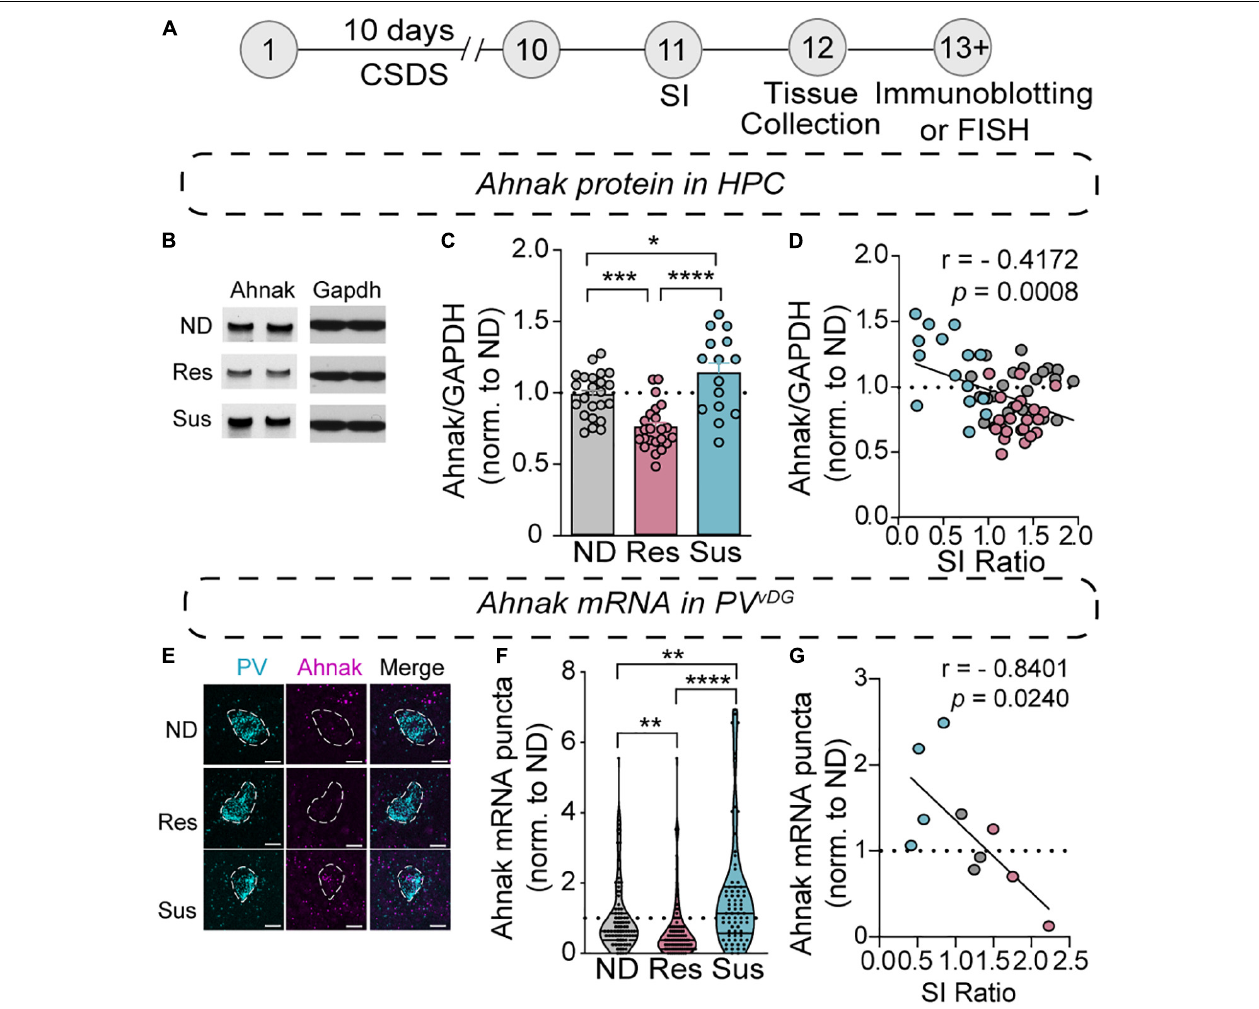
FIGURE 4 | Chronic social stress alters Ahnak expression in the hippocampus. (A) Diagram and timeline of CSDS and tissue collection. (B–D) Immunoblotting of Ahnak protein using hippocampal lysates. (B) Representative images of immunoblotting of Ahnak and Gapdh as a control. (C) Quantification of immunoblots [one-way ANOVA, Non-defeated ( n = 23 mice), Res ( n = 23 mice) and Sus ( n = 15 mice)]. (D) Hippocampal Ahnak is inversely correlated with SI ratio (pearson r : r = –0.4172, p = 0.0008, n = 61 mice) (E) Representative images PV and Ahnak mRNA expression using RNAScope. Scale bar, 5 µ m. (F) Ahnak mRNA expression in vDG PV neurons from Non-defeat, Res and Sus groups (Kruskal–Wallis test with post hoc Dunn’s multiple comparisons: Non-defeated ( n = 102 cells), Res ( n = 94 cells) and Sus ( n = 73 cells). (G) Ahnak mRNA expression in vDG PV neurons is inversely correlated with SI ratio (pearson r : r = –0.8401, p = 0.0240, n = 10 mice). All data were normalized to ND group. * p < 0.05, ** p < 0.01, *** p < 0.001, **** p <